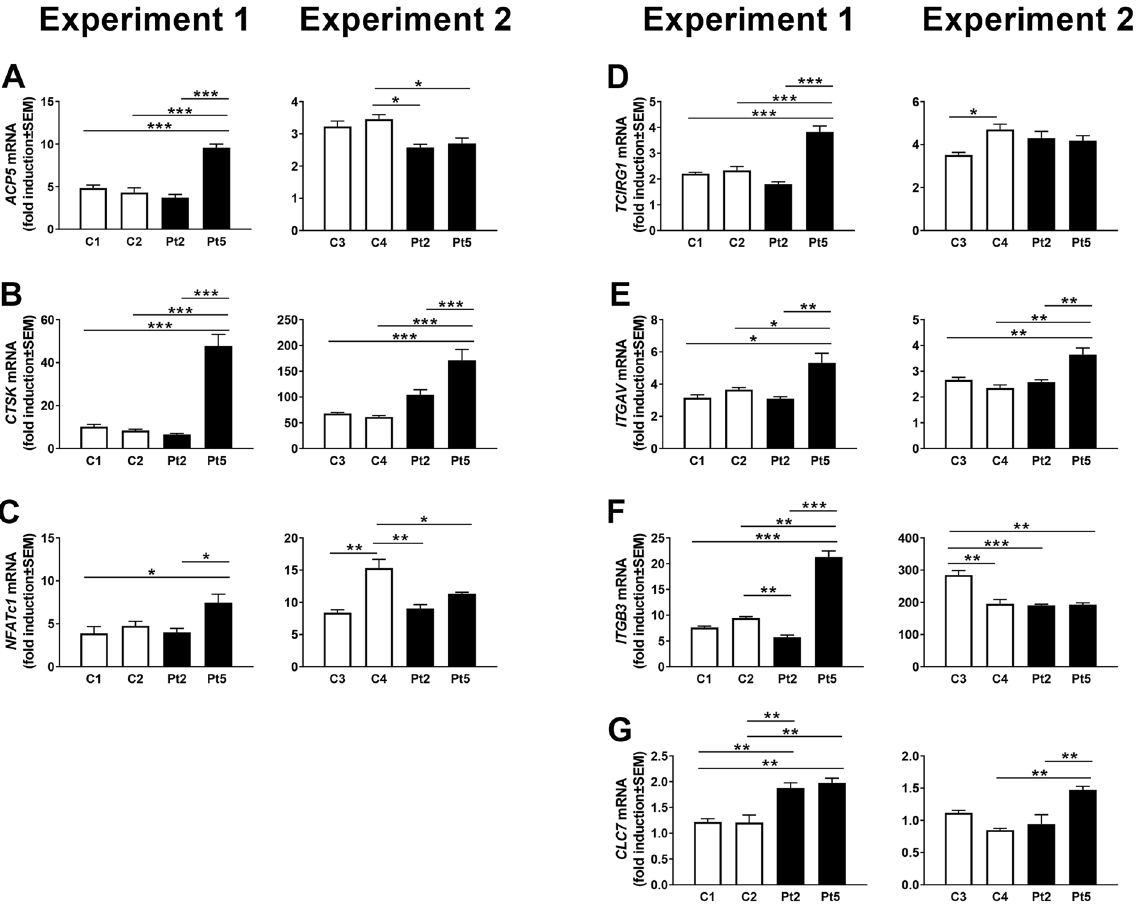
Figure 3. Gene expression in osteoclasts from patients (Pt2, Pt5), and controls (C1, C2, C3, C4). Fold induction of gene expression between cells treated with M-CSF (M) with and without RANKL (RL) for three days. All values are given as mean ± SEM (n = 4). * P ≤ 0.05, ** P ≤ 0.005, *** P ≤ 0.001 between indicated